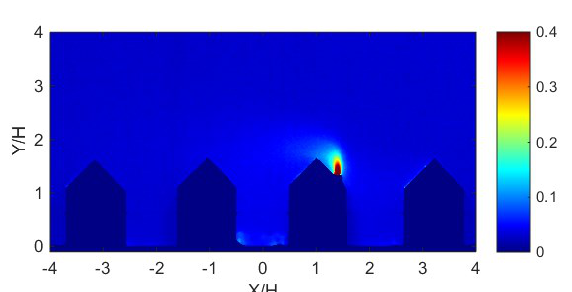
Fig. 15. Mean non- dimensional concentration C/C 0 field (C 0 is the mean concentration measured at the top of the chimneystack) for pitched roof and a chimneystack (on the downstream pitch) with h/H = 0.25; the flow moves from the right to the